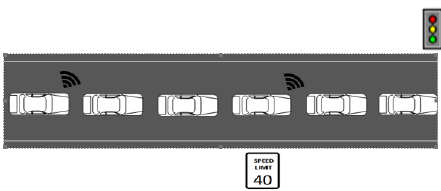
Figure 1. Tested link section includes connected vehicles (CVs) and